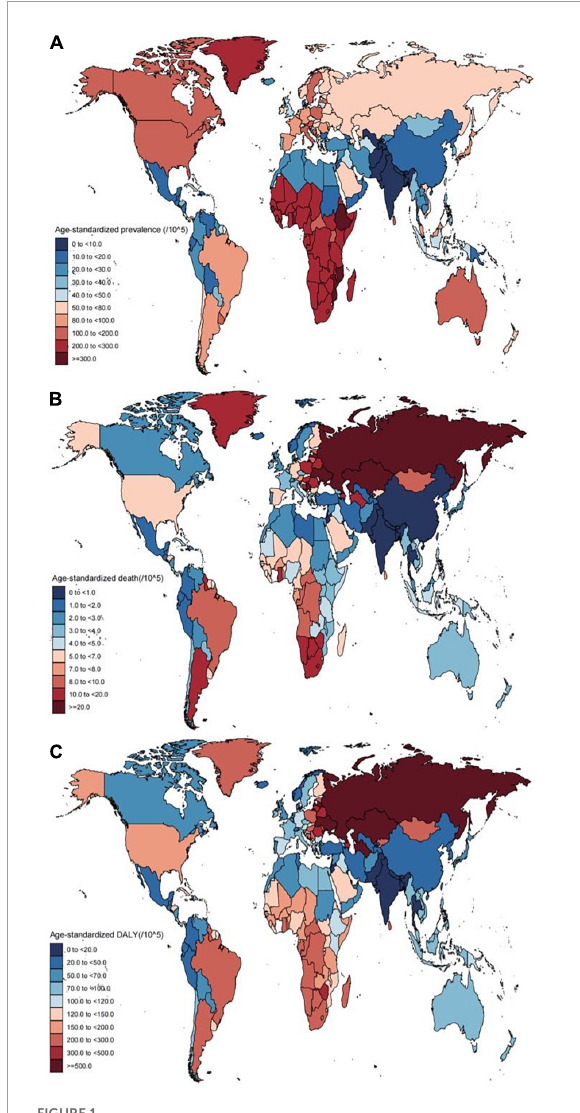
FIGURE1 Age-standardized prevalence rates (A) , death (B) , and DALY (C) of cardiomyopathy for 204 countries and territories, both sexes, 2019. DALY, disability-adjusted life